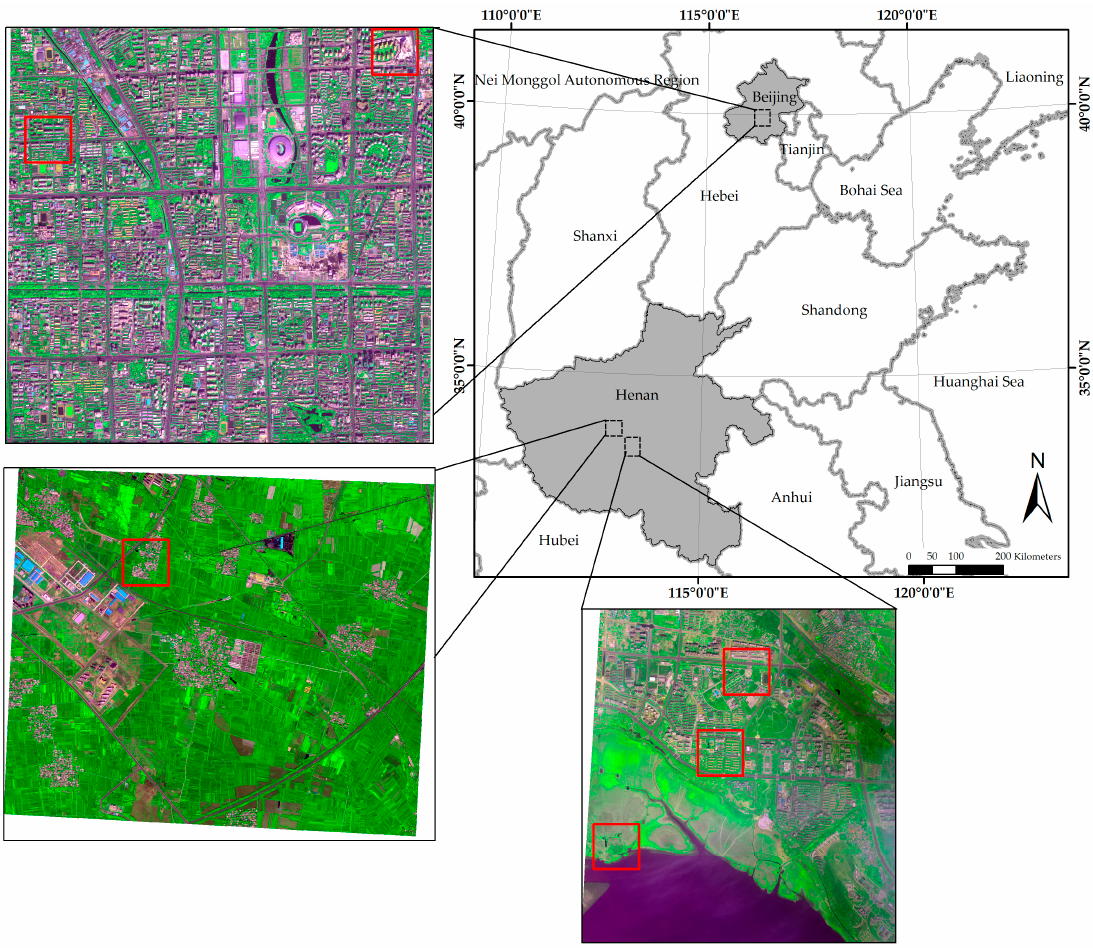
Figure 1. The locations of the three WV-2 scenes employed in this work. The locations of the six test images used in the experiments are marked by the rectangles in red.